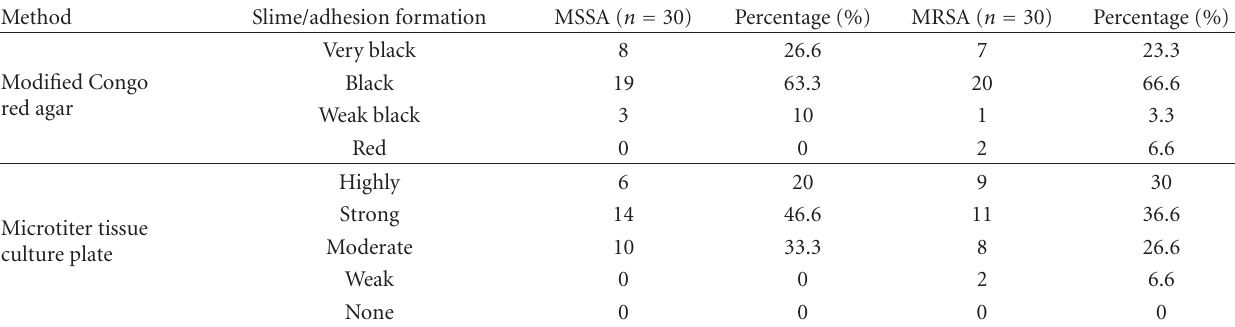
Table 2: Slime production and adhesion formation by microtiter tissue culture plate and modified Congo red agar method. Method